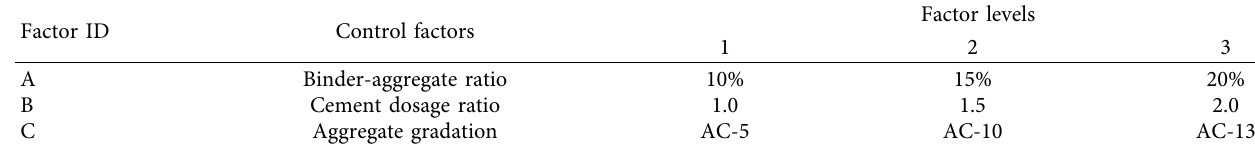
Table 7: Factor level values.